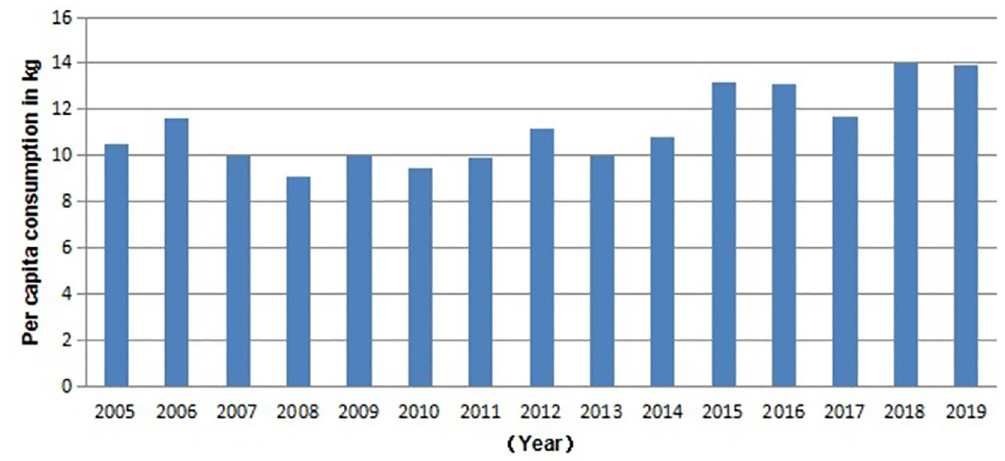
Fig 3. Per capita consumption of mutton in Xinjiang, 2003–2017 (kg). Note : The data sources are arranged according to Xinjiang Statistical Yearbook